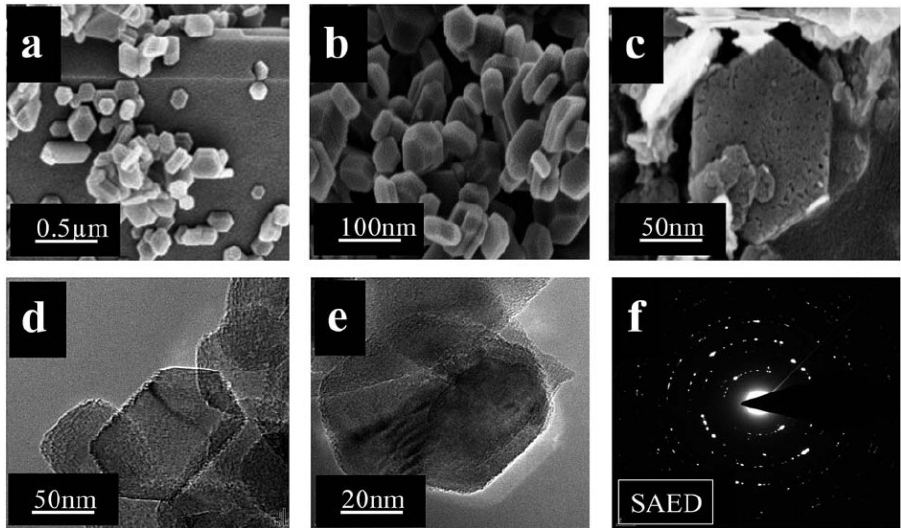
Figure 6. FESEM ( a – c ) and FETEM ( d , e ) images, and SAED pattern ( f ) of MgO nanohexagons obtained in bis(3-methyl imidazolium-yl) butane dichloride [74]. Copyright Royal Society of Chemistry, 2006.